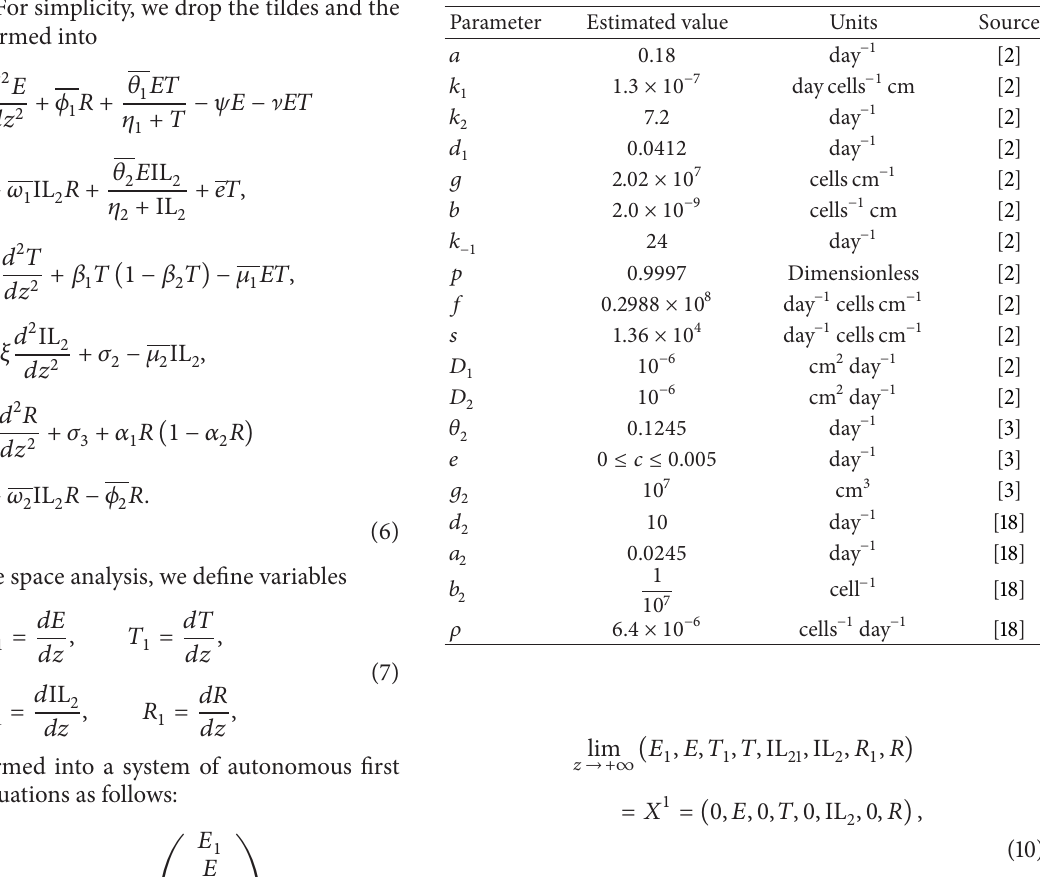
Table 1: Dimensional parameter values for model